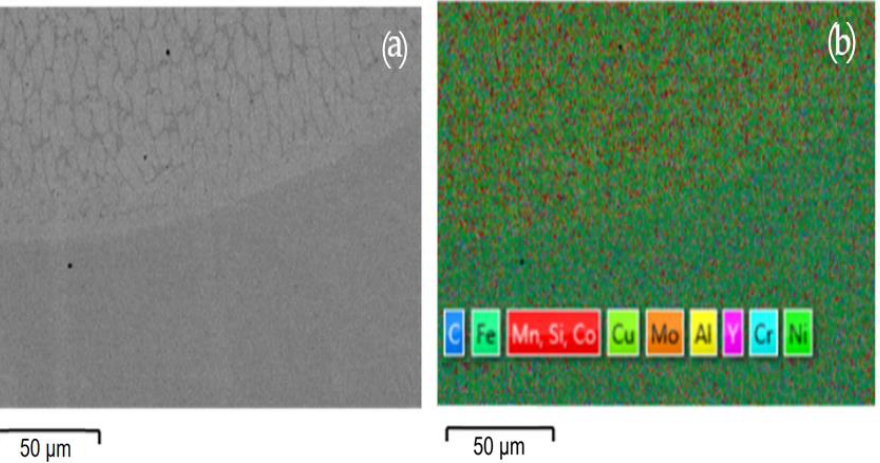
Figure 11. EDS of the clad bonding zone: ( a ) bonding zone morphology and ( b ) bonding zone energy spectrum.